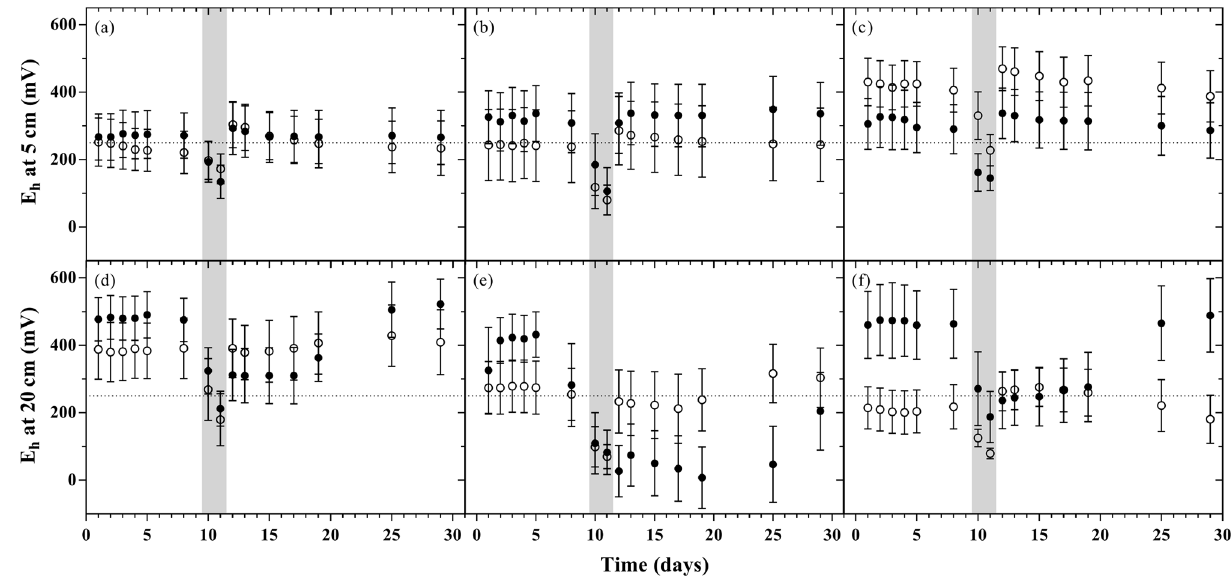
Figure 3. Redox potential relative to standard hydrogen electrode during the flooding–drying experiment at 5 and 20cm depth (mean ± SE; n = 6); unamended soils ( a and d ), litter addition ( b and e ) and plant treatment ( c and f ). LA (filled circles) and SA (open circles); the dotted line at 250mV marks the threshold, below which denitrification is expected to